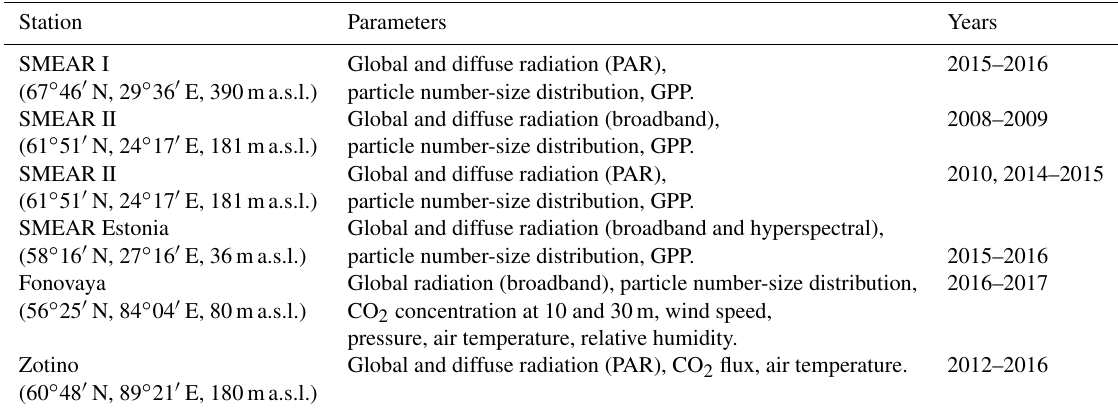
Table 1. Data sets from different sites used in this study.